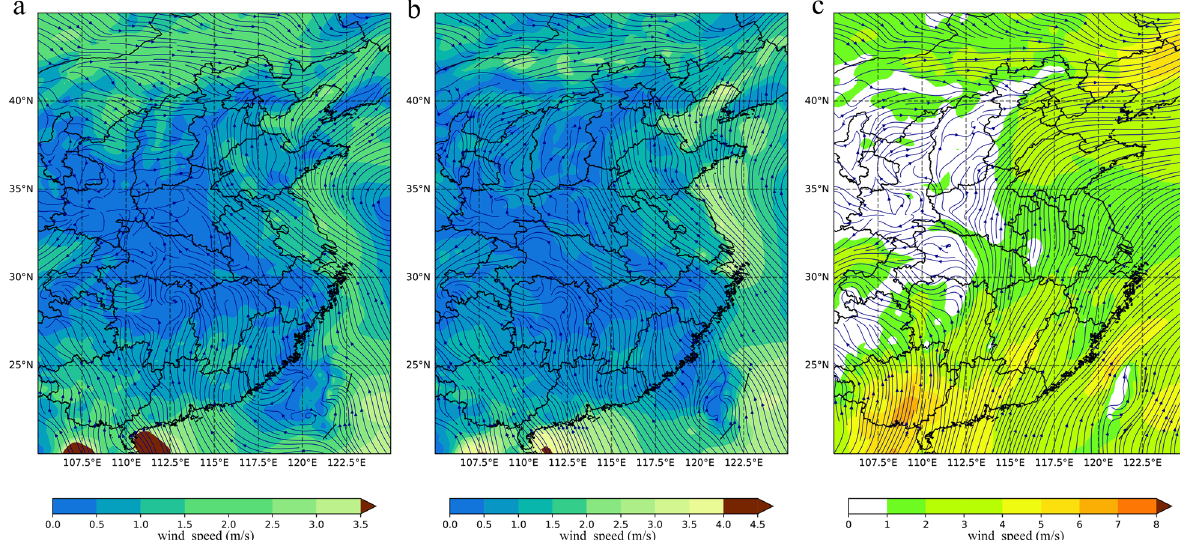
Fig. 5 Average horizontal wind field from April to June supports airflow driving force for Pt urediniospores from the south to north. Colored areas show different wind speeds, and the wind field streamlines and directions are shown with dark blue arrows. a Average horizontal wind field at 10 m altitude from April to June 2020. b Average horizontal wind field at 10 m altitude from April to June in 2016–2020. c Average horizontal wind field at 900 hPa from April to June in